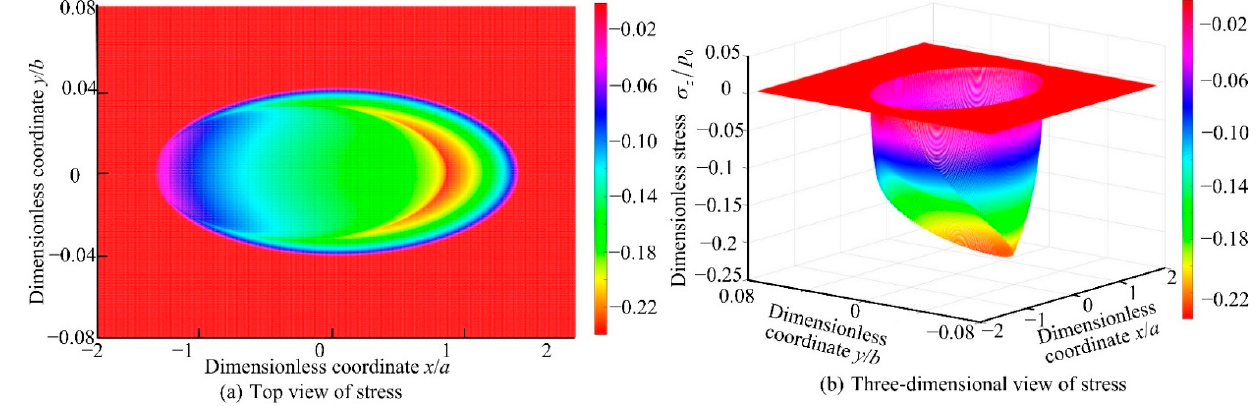
Figure 7. Distribution of dimensionless stress τ xz / p 0 for k = 0.8 and µ = 0.15. Figure 8 is the variation law of stress components σ x / p 0 for fixed values of µ = 0.15